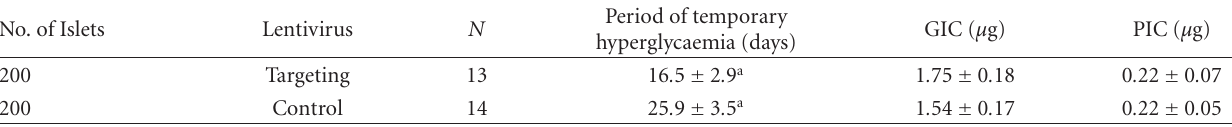
Table 3: E ff ect of p27 Kip1 silencing on the period of temporary hyperglycaemia and insulin contents of islet graft and pancreatic remnant. Batches of 200 isogeneic islets with targeting and non-targeting (control) transduction were implanted in the subcapsular space of the left kidney of B6 mice with streptozotocin-induced diabetes. After transplantation, blood glucose was measured, and the duration of temporary hyperglycemia was the period between transplantation and the stable restoration of normoglycemia ( < 200mg/dL). The graft-bearing kidneys were removed 12 weeks after transplantation for the measurement of insulin contents. The pancreatic remnants were removed 2 weeks after nephrectomy for measuring the insulin content. a P < 0 . 05 when the indicated means were analyzed using unpaired Student’s t